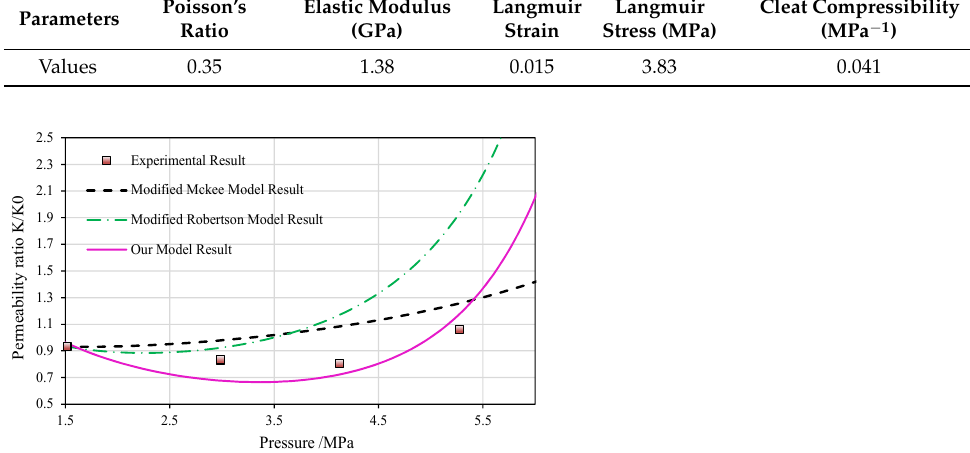
Figure 14. Calculation results of the permeability models and the corresponding experimental data. Table 4. Mechanical properties and swelling parameters obtained from Robertson (2005) [35].